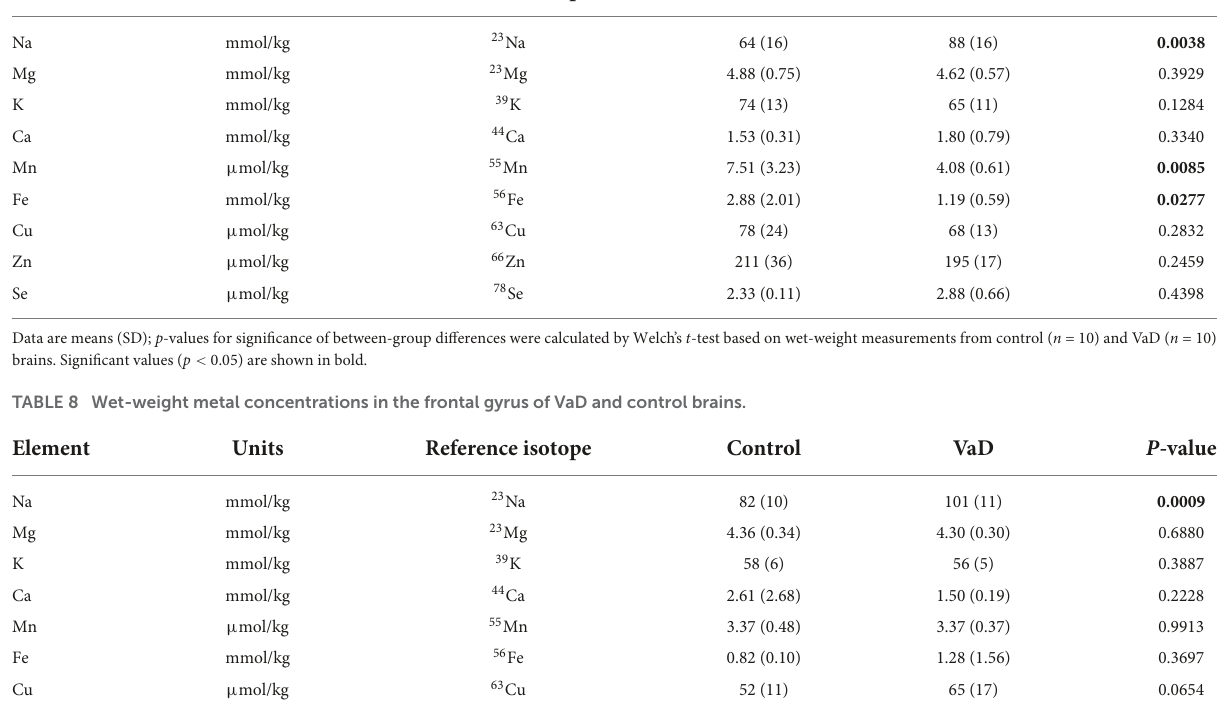
TABLE 7 Wet-weight metal concentrations in the occipital cortex of VaD and control brains. Element Units Reference isotope